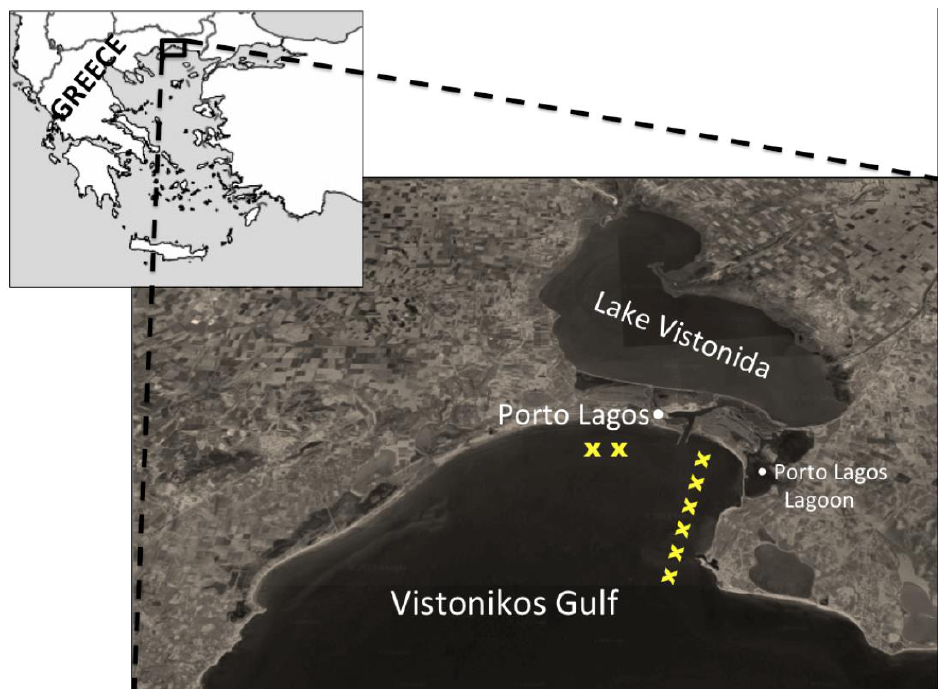
Figure 1. Satellite image map showing the study area. Mussel farms’ locations are indicated with yellow “x”. There is a possible area of expansion of the mussel farming area towards the southeastern direction.